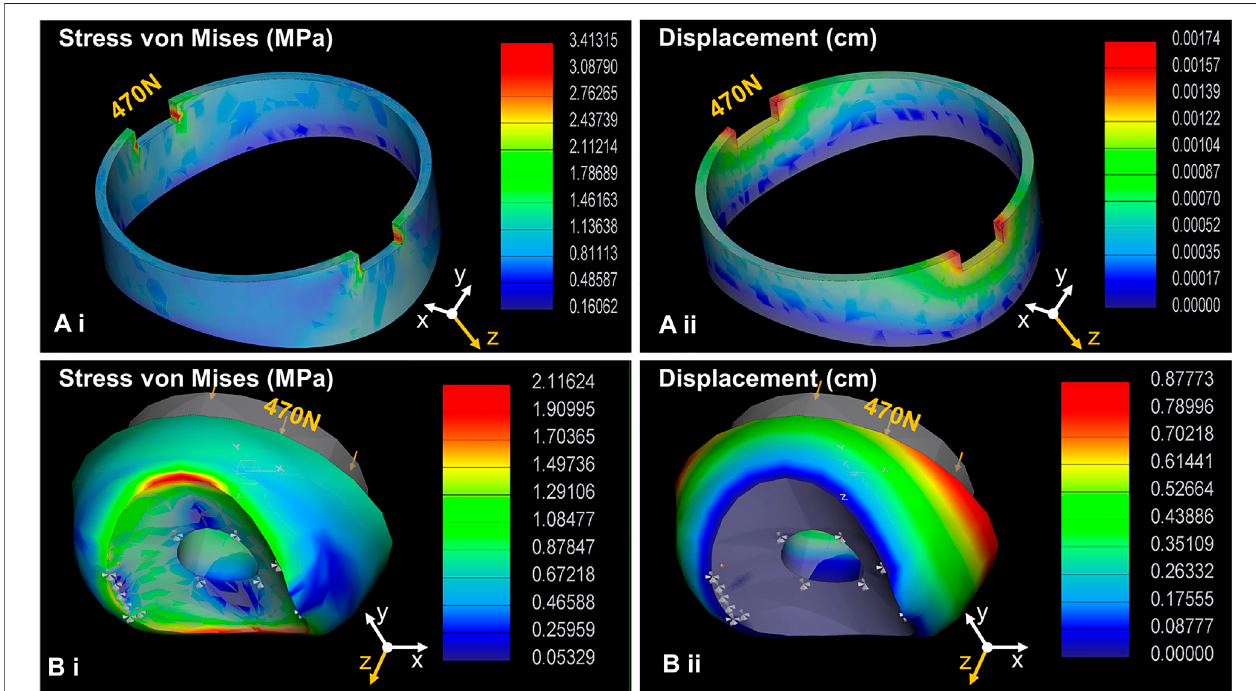
FIGURE 5 | The robot-foot design relies heavily on the way it interacts with a surface. The fi rst contact point on the surface is proposed as foot-toes along with the electromagnet. The electromagnet has a steel-case strong enough to bear the magnet ’ s maximum attachment force (approximately 470 N representing the force